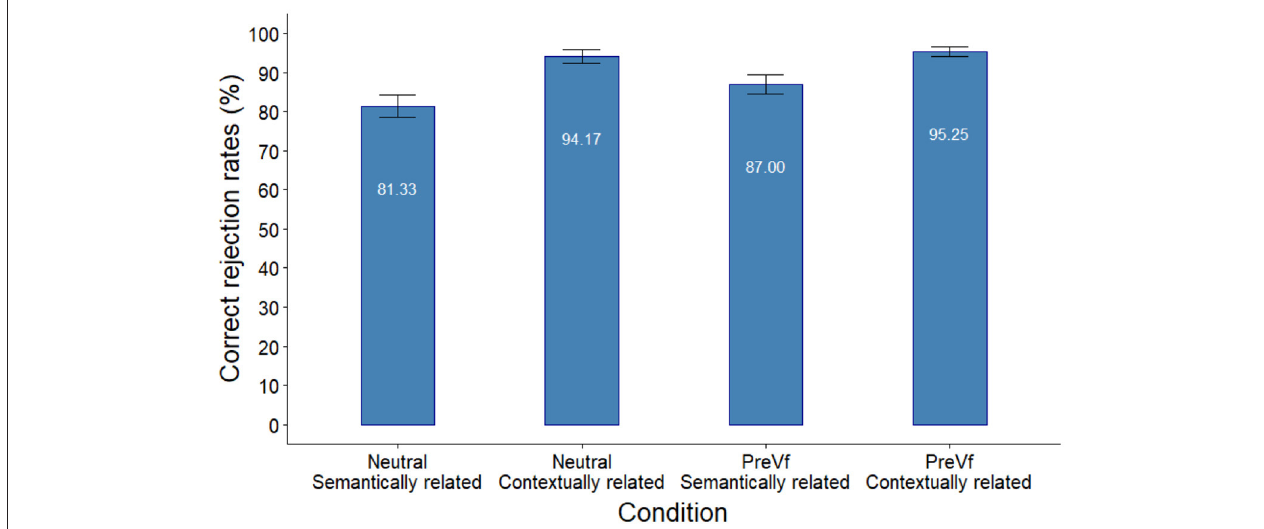
FIGURE 2 | Accuracy rates in the different probe conditions in Experiment 1. Error bars indicate the standard error of the mean.